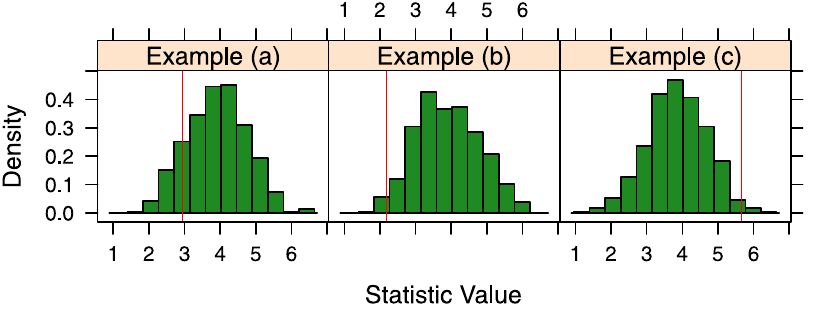
Fig. 3. Results of the systemic test for the Bradley-Terry assumption. The sampling distribution of the test statistic for each of the three examples shown in Figure 2 is displayed by the histograms. The red line indicates the value of the test-statistic.